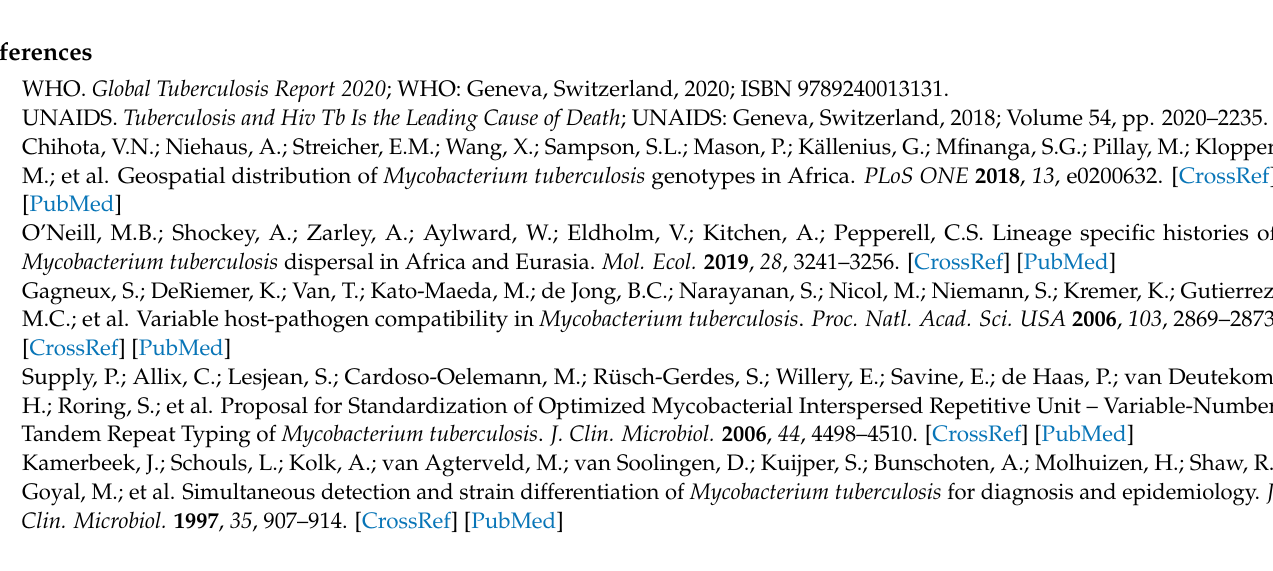
representative L3.1.1 strains by country to Zambian strains. The differences in median SNP distance were significant ( p < 0.000). Only countries with more than 10 strains were considered. Supplementary Figure S3: Map showing the residence districts of the 12 patients highlighted in different colors. Seven patients were from Lusaka, and one from Chikankata. Monze and Kabwe had two patients each. Supplementary Table S1: Number of L3.1.1 global strains from each country that were successfully analyzed. Supplementary Table S2: Information on the 12 CAS1-Kili Zambian